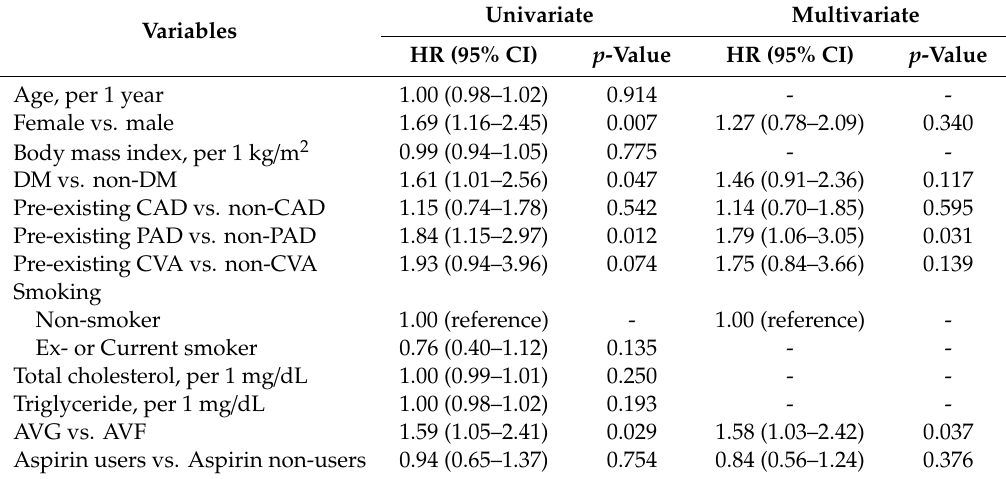
Table 4. Cox proportional regression analysis for vascular access failure event (primary outcome) in the propensity-matched